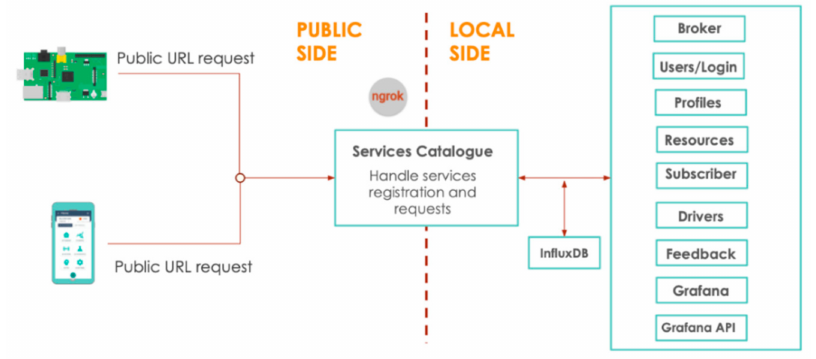
Figure 3. System overview for